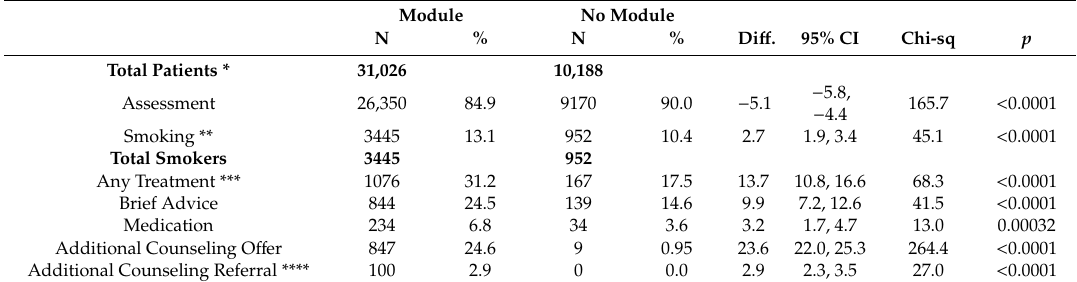
Table 5. Smoking prevalence and treatment in cancer clinics by use of the ELEVATE module. Module No Module N % N % Di ff . 95% CI